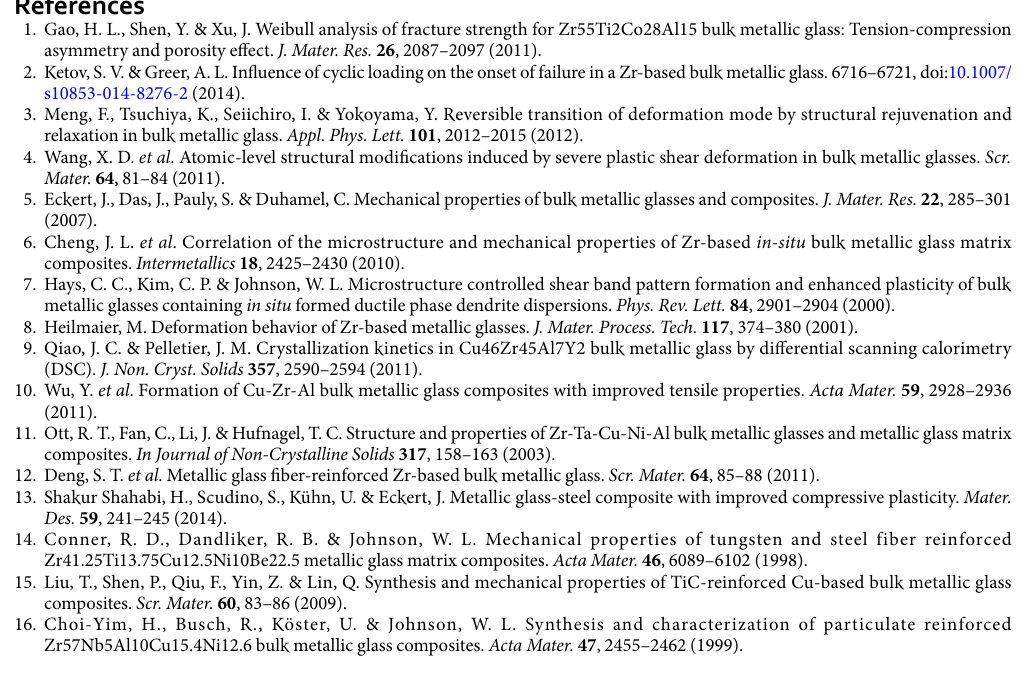
7 ScIEntIfIc RePORTs | 7: 6651 | DOI:10.1038/s41598-017-06424-4